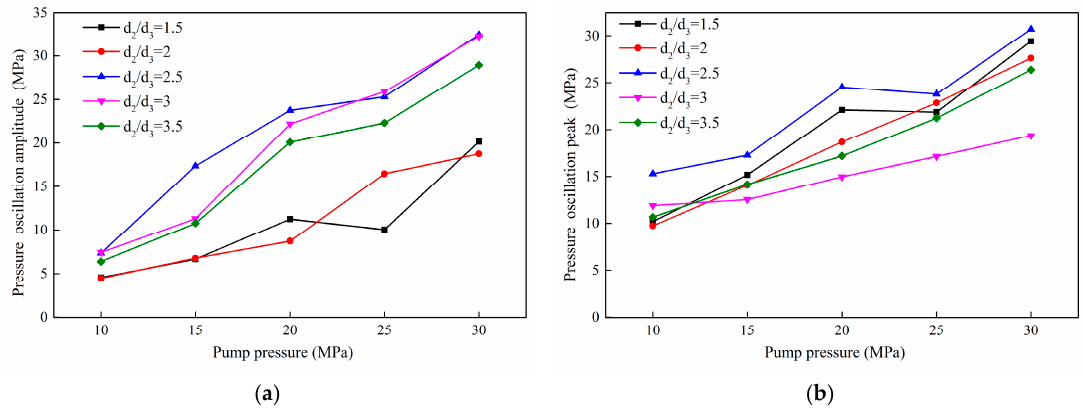
Figure 11. Performance of different d 2 / d 3 nozzles under each pump pressure. ( a ). maximal jet pressure pulsation amplitudes of different d 2 / d 3 nozzles. ( b ). maximal jet peak pressures of different d 2 / d 3 nozzles at each pump pressure.